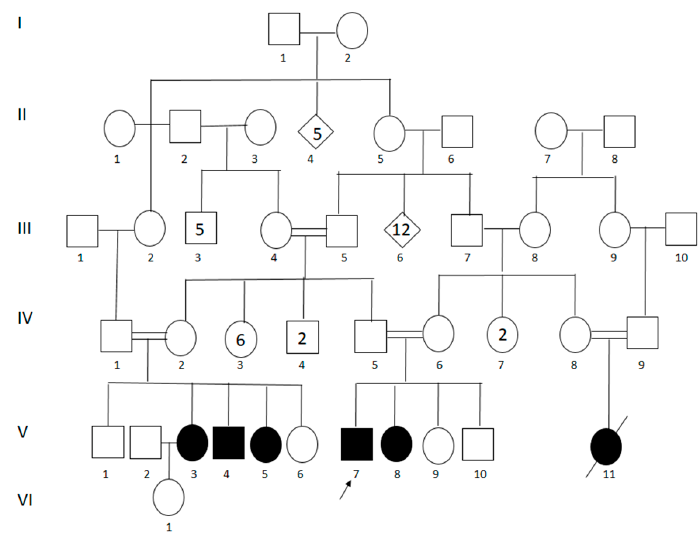
Figure 1. Genealogical tree revealing consanguinity. V3: case 1; V4: case 2; V5: case 3; V7: case 4; and V8: case 5. Numbers inside of the symbols represent the sum of the individuals with this standard representation.